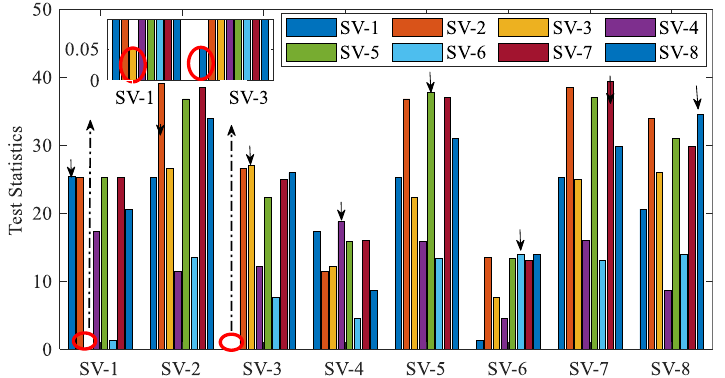
Figure 11. Statistics for GNSS fault exclusion when faults occur in SV-1 and SV-3.